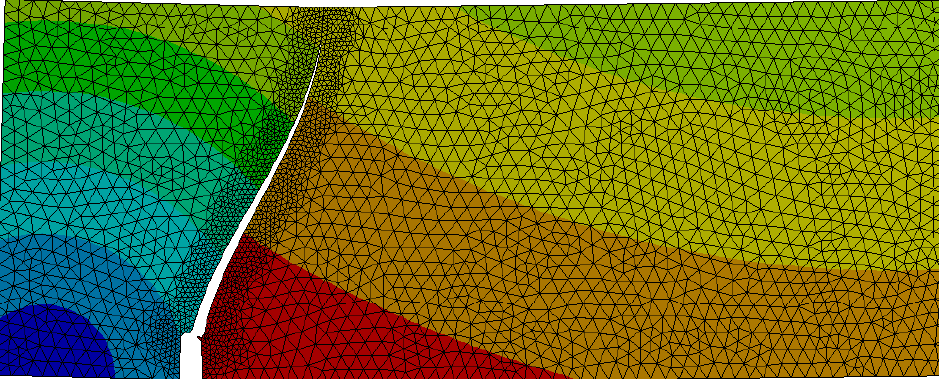
Figure 7. Predicted rack growth path for specimen 2.